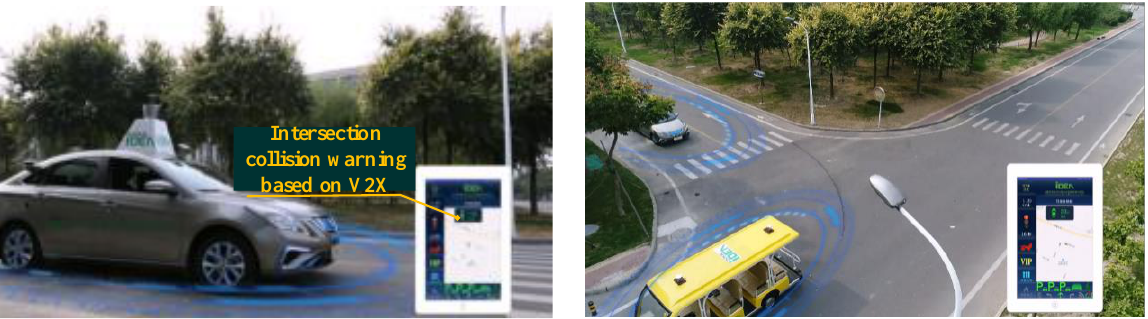
Figure 26. Intersection collision warning based on V2X.